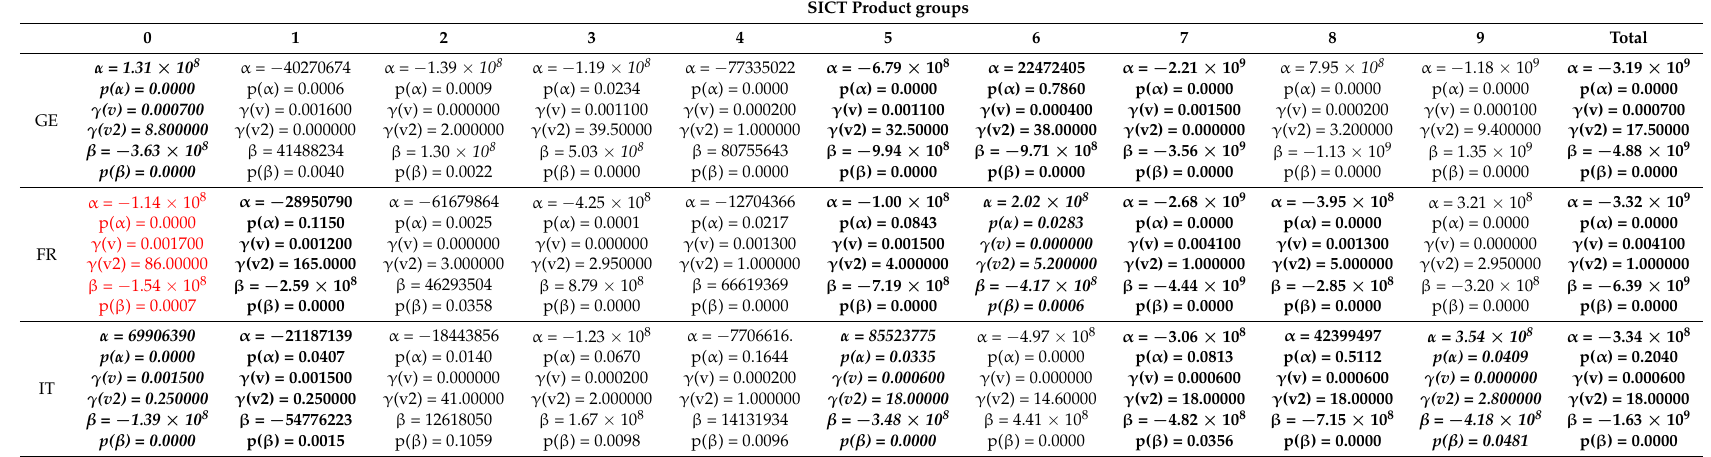
Table A6. Hysteresis with a variable play area and two uncertainty variables (EPUI,